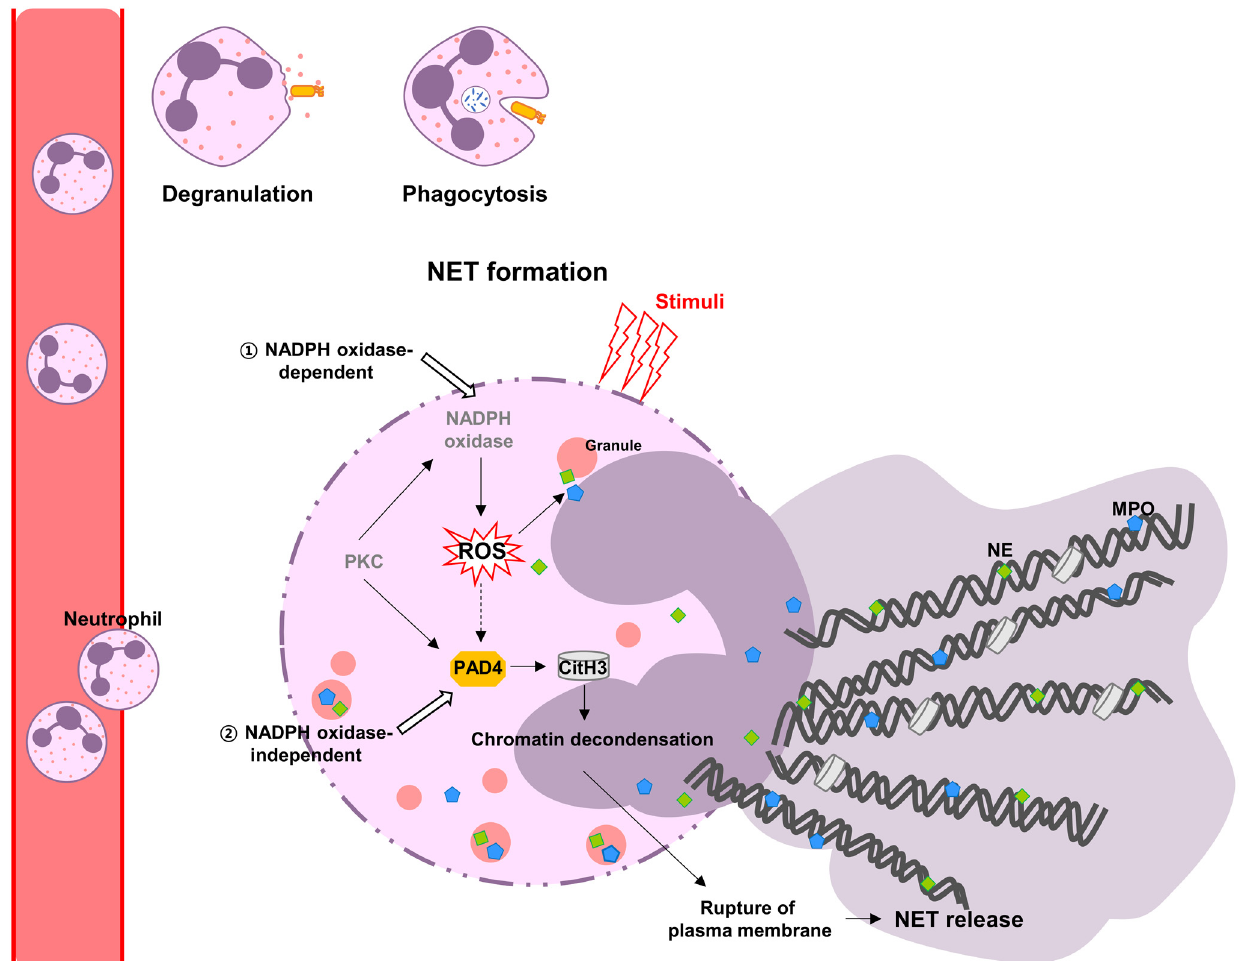
Figure 1. NADPH oxidase-dependent or -independent NET formation. Neutrophils eliminate invading pathogens through phagocytosis, degranulation, and NET formation. ① NADPH oxidase- mediated ROS stimulates MPO and NE to promote translocation from neutrophil granules into the nucleus and trigger the release of NETs. MPO binds chromatin with NE and contributes to the decondensation of chromatin, and then the nuclear membrane is disrupted. ② Activated PAD4 citrullinates histones, causing chromatin decondensation. NETs are released into the extracellular space to capture invading pathogens.